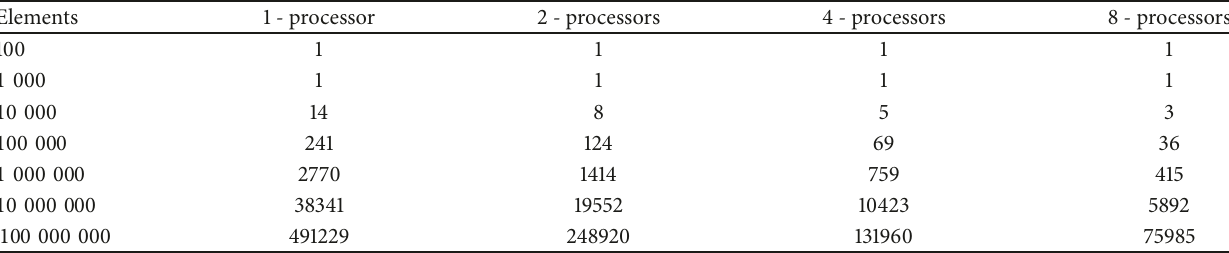
Table 1: Average benchmark sorting time for 100 samples in